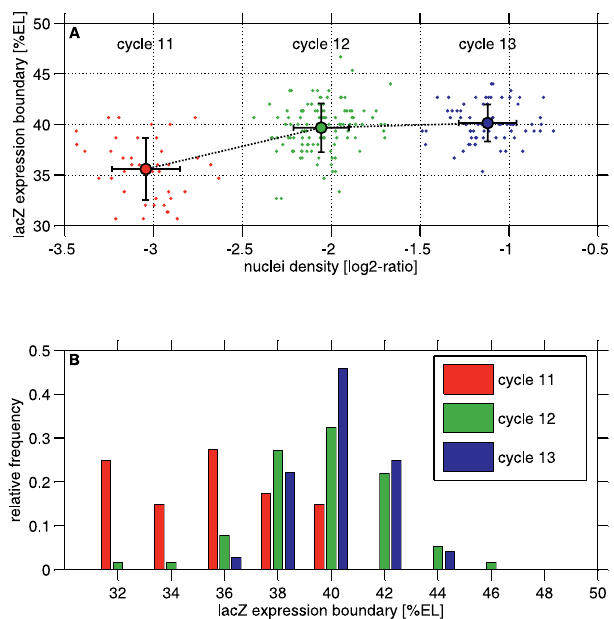
Figure 4. Analysis of Bcd-Dependent lac Z Reporter Expression over Cleavage Cycles 11, 12, and 13 The posterior boundary of the lac Z expression domain is shown as a function of the normalized nuclear density for each embryo (colored dots). Embryos fall into three classes of nuclear density corresponding to their cleavage cycle (11, red; 12, green; and 13, blue). Average nuclear density and domain boundary for each cycle are indicated by big circles, and whiskers denote standard deviations. (B) The distribution of the expression boundary is shown for the three cycles (bin size is 2% EL). Note the progression in time of the boundary.